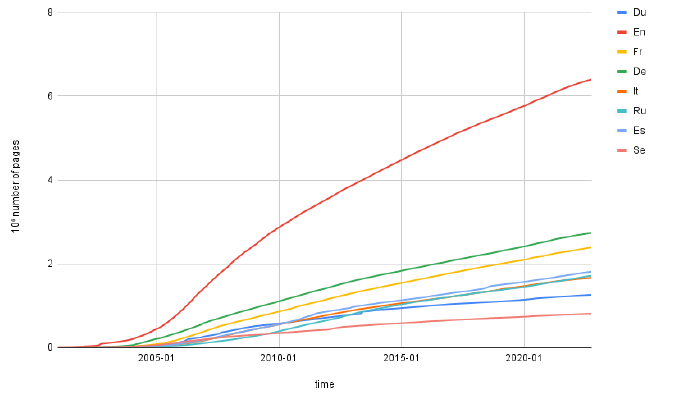
Figure 7. Time evolution of number of pages created by users of some of the biggest Wikipedia editions. Codes: Du = Dutch, En = English, Fr = French, De = German, It = Italian, Ru = Russian, Es = Spanish, Se = Swedish. Data collected from [33].